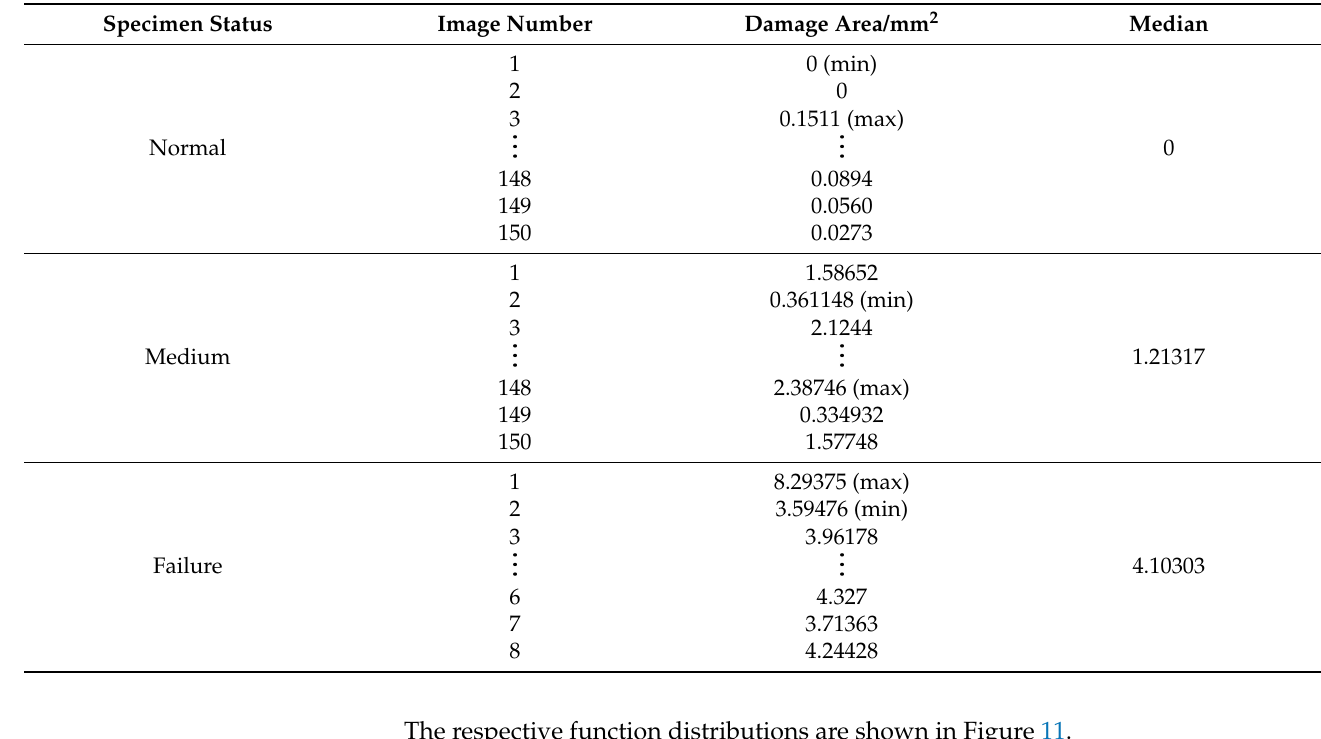
Table 12. Damage area statistics table.